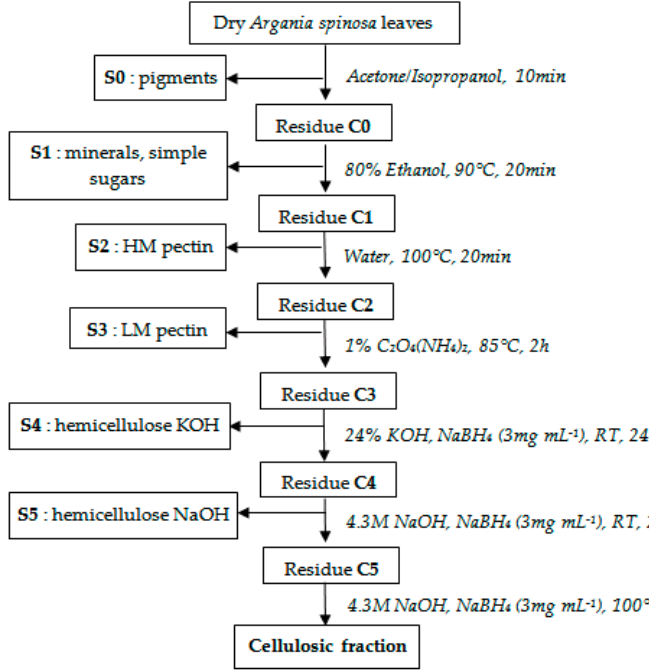
Figure 3. Extraction and isolation of polysaccharide fractions.